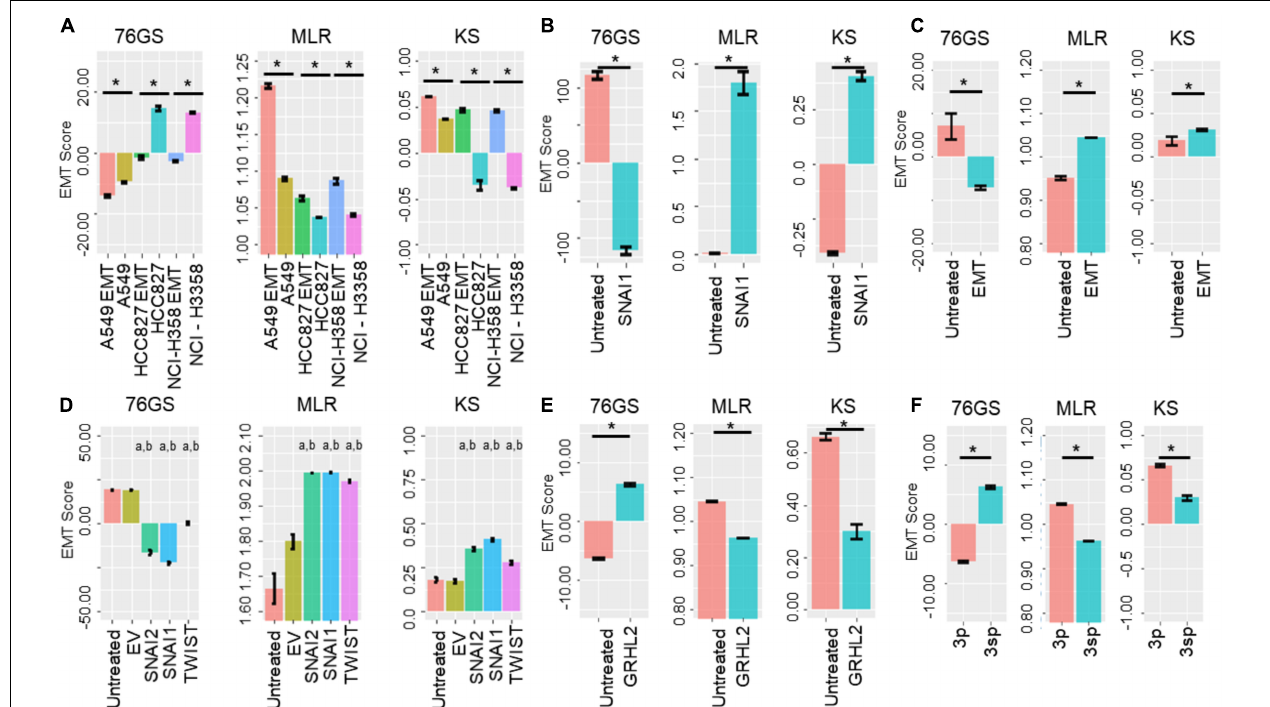
FIGURE 5 | Bar plots showing EMT scores of different cell lines calculated using the three EMT scoring methods. (A) EMT induction is shown in three cell lines – A549, HCC87, and NCIH358 (GSE49664). (B) EMT induction in MCF7 cell line (GSE58252). (C) EMT induction in EpRas cells (GSE59922). (D) EMT induction by different EMT-inducing transcription factors. “a” denotes statistical significant difference ( p < 0.05, n = 3, two-tailed Student’s t -test) for pairwise comparison of a given set with untreated (first column), “b” denotes the same when compared with empty vector (EV; second column) (GSE43495). (E) MET induction by GRHL2 in MDA-MB-231 cell line (GSE36081). (F) Two cell lines of hepatocellular carcinoma with varying EMT status (GSE26391). Each control case has been compared to EMT/MET induced case (* p < 0.05, n = 3, two-tailed Student’s t -test; error bars represent standard deviation).